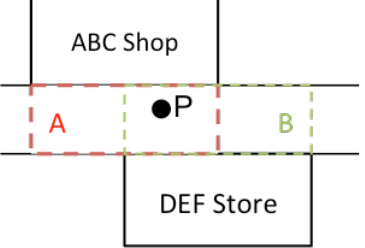
Figure 5. Indoor area is divided into cognitive collages by references, and cognitive collages can be overlaid.